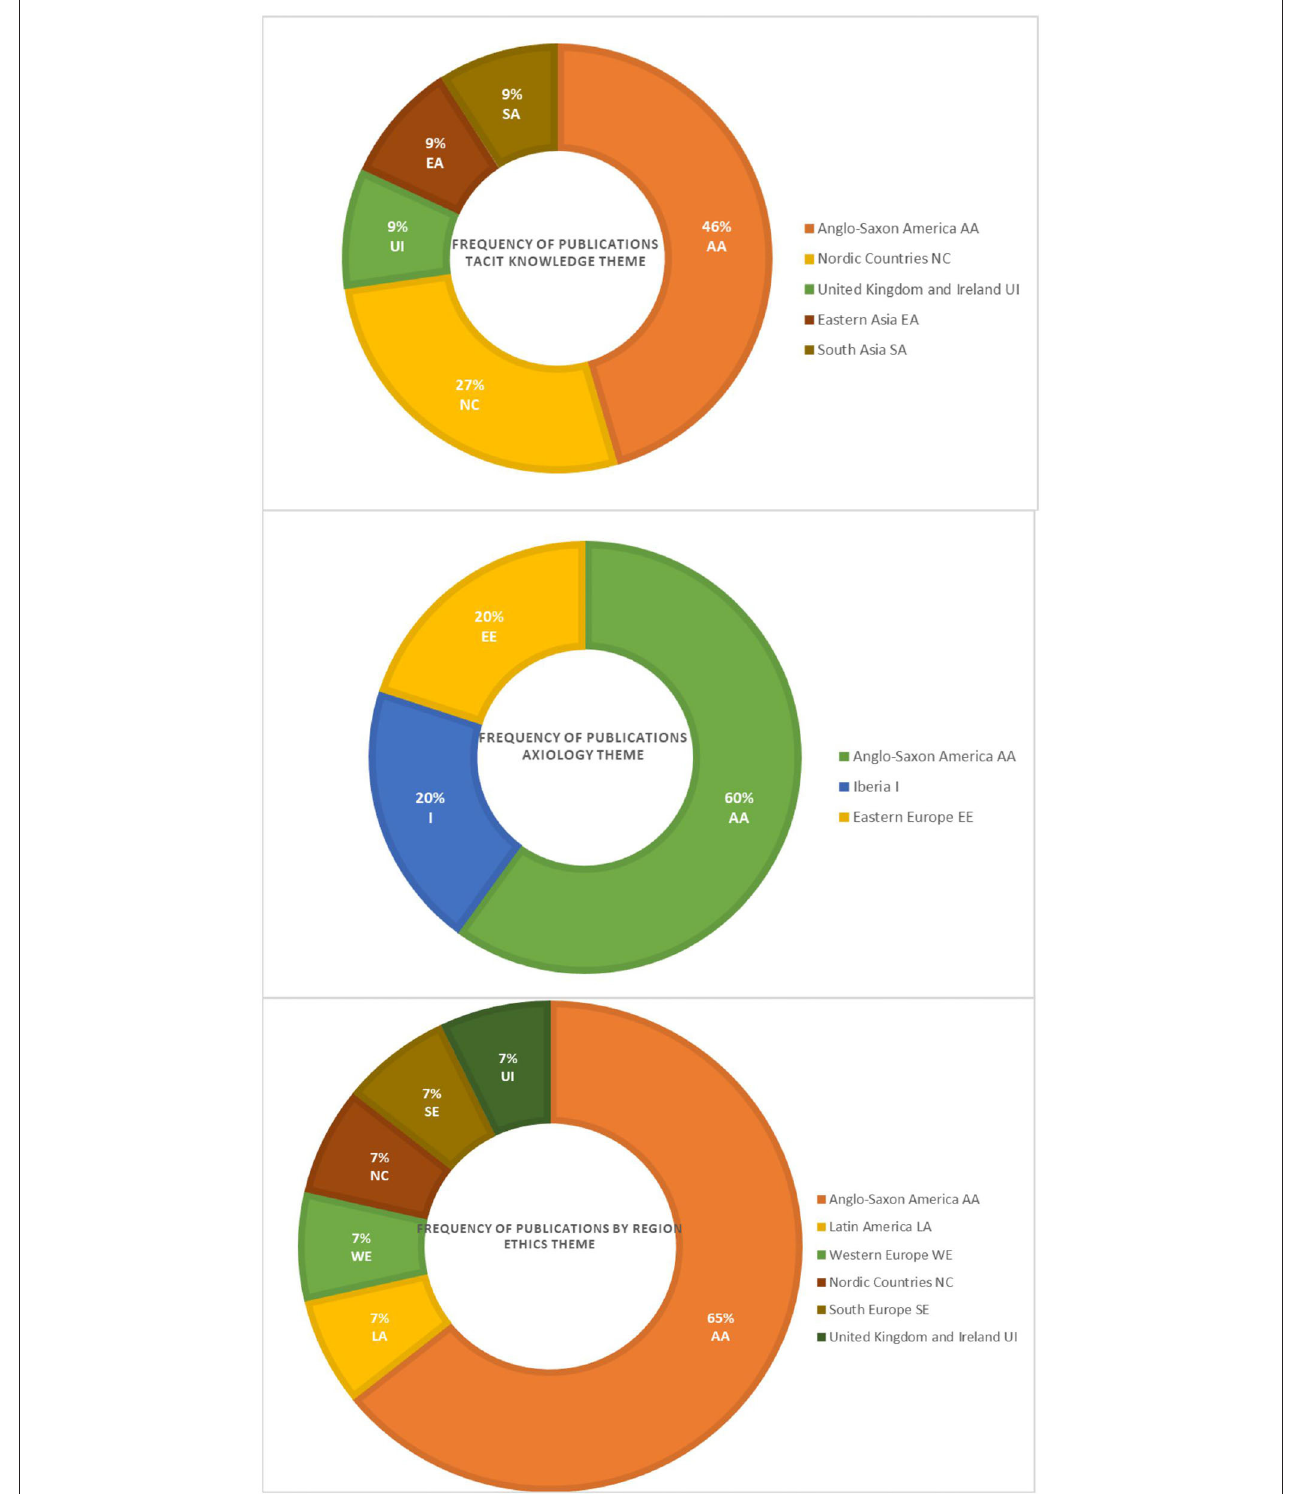
FIGURE 3 | Article’s production by region and the main theme.